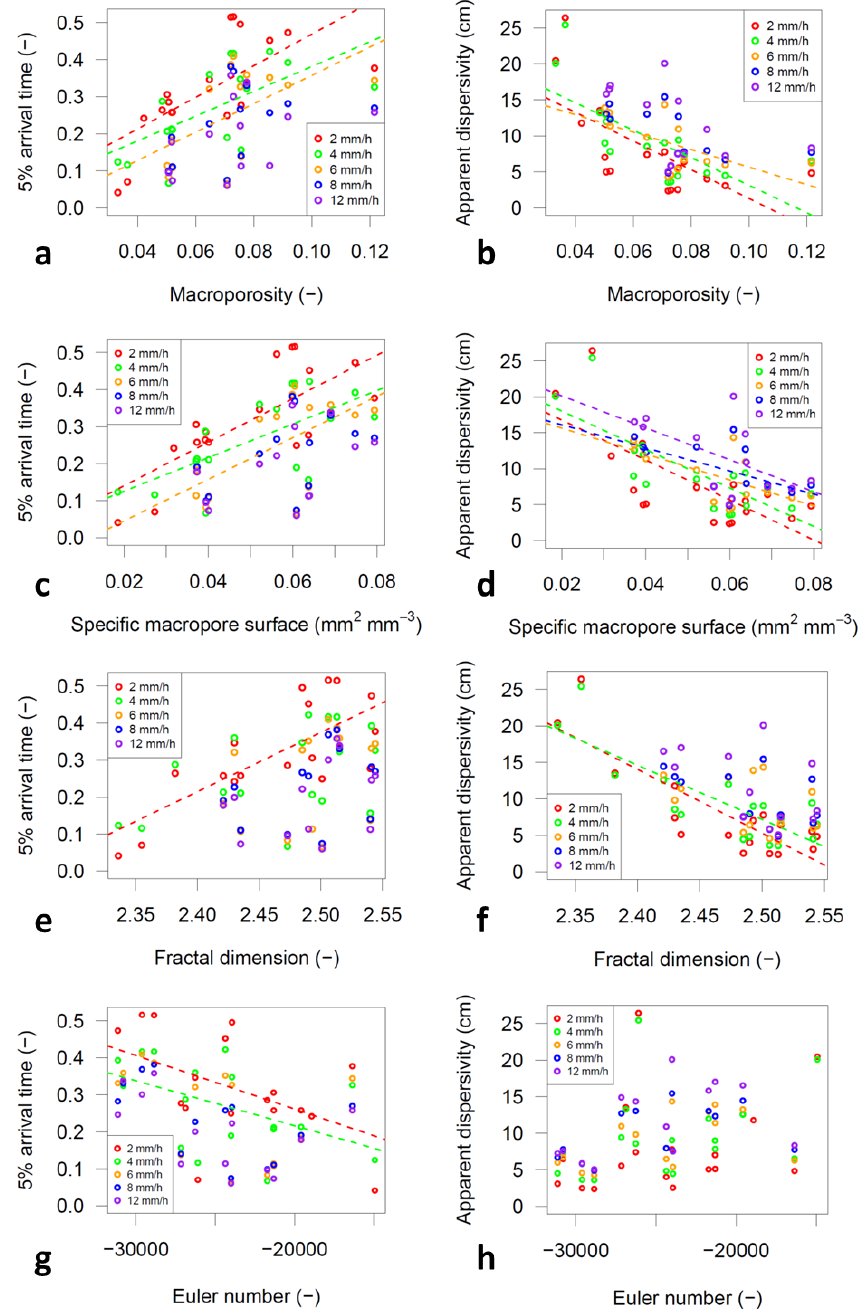
Figure 8. Relationship between macropore characteristics and measures of preferential transport for the four soils. Linear regression lines (dashed) were drawn if the slope was significantly ( p value <0.05) different from